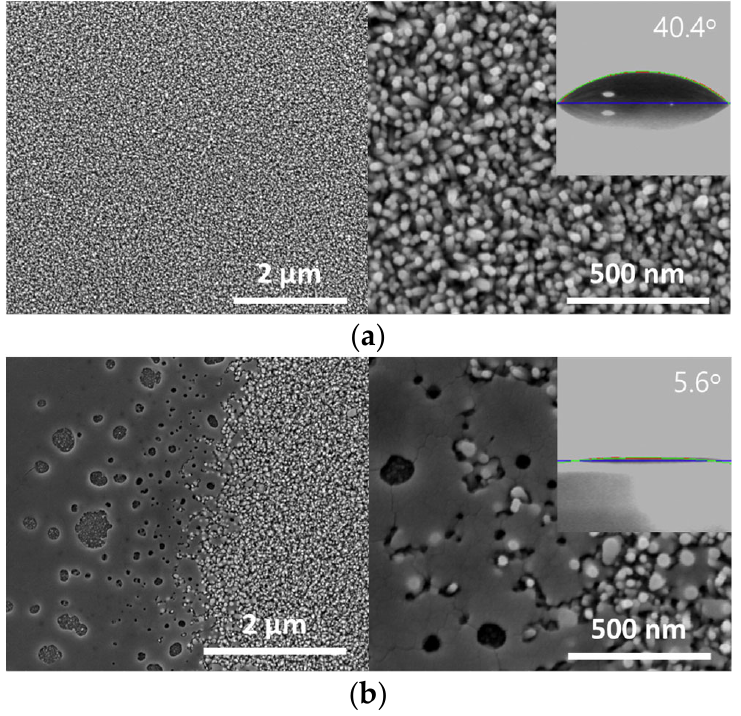
Figure 2. FE-SEM top-view images of surface nano-morphologies of ZnO-PEOTES coatings and contact angle images of TGME on the coatings: ( a ) before laser treatment, ( b ) after laser treatment.